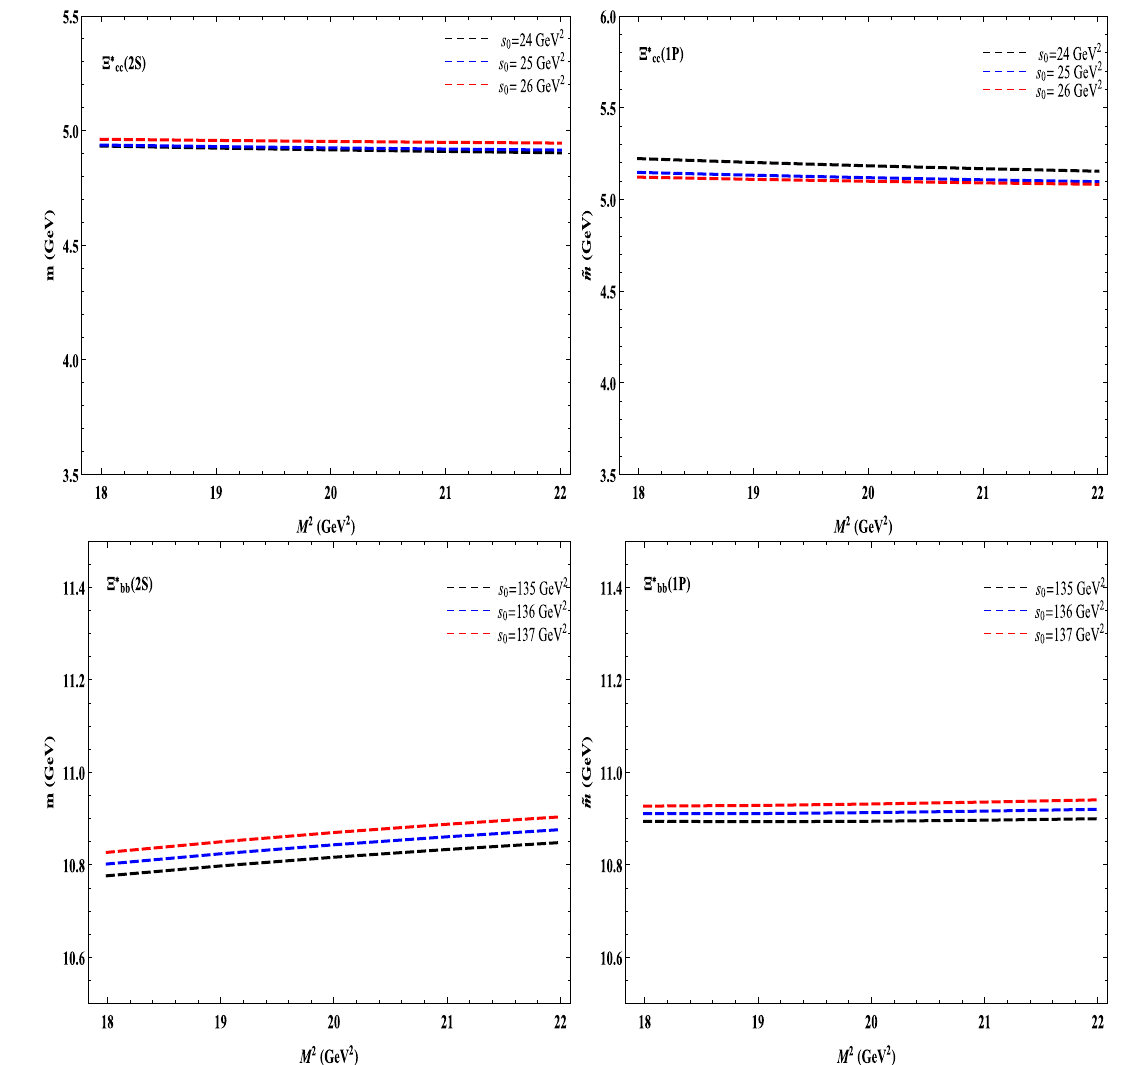
baryons on the Borel mass M 2 at different bb